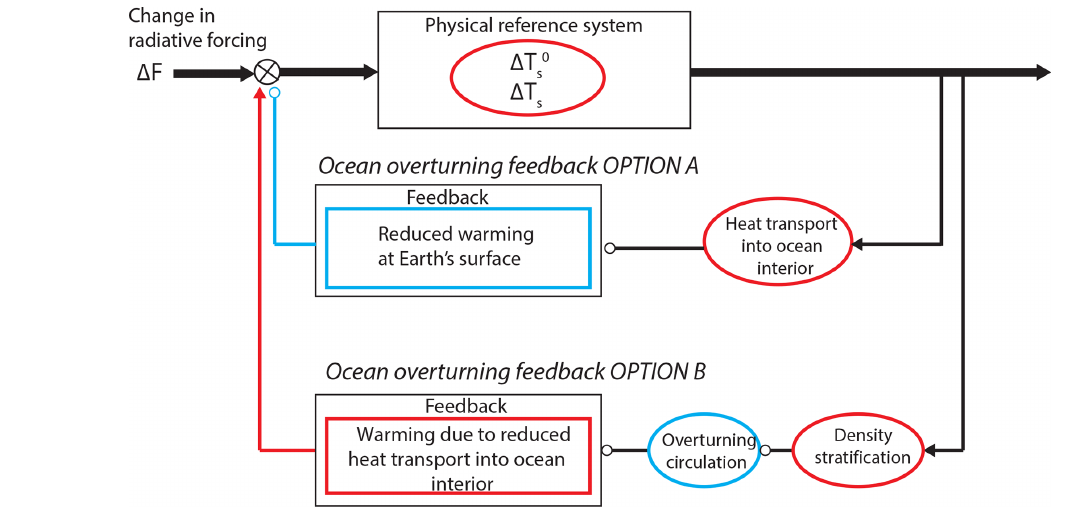
Figure 11. Schematic of the slow ocean–atmosphere feedback. Arrows indicate positive coupling; open circles indicate negative coupling. Changes in state variables are indicated by ellipses, changes in processes by rounded rectangles. Red indicates increasing values of variables, strengthening of processes, or positive feedbacks; blue indicates the opposite. The change in surface air temperature (cid:49)T s in the presence of feedback is different to the change (cid:49)T 0 s without